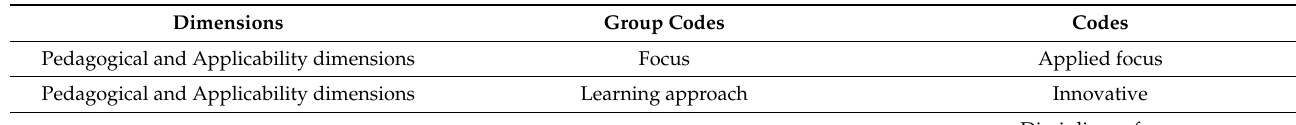
Table A1. Relationship between dimensions, code groups and codes from the analysis conducted in this